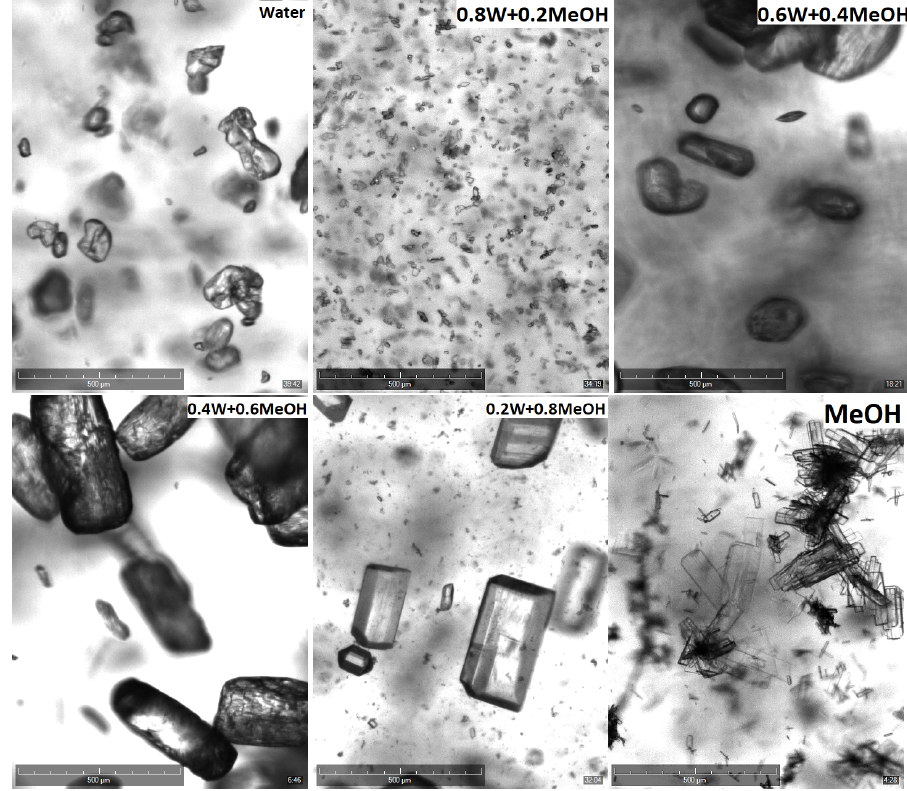
Figure 11. Images of ascorbic acid crystals in water-methanol solvent systems (scale: 500 µ